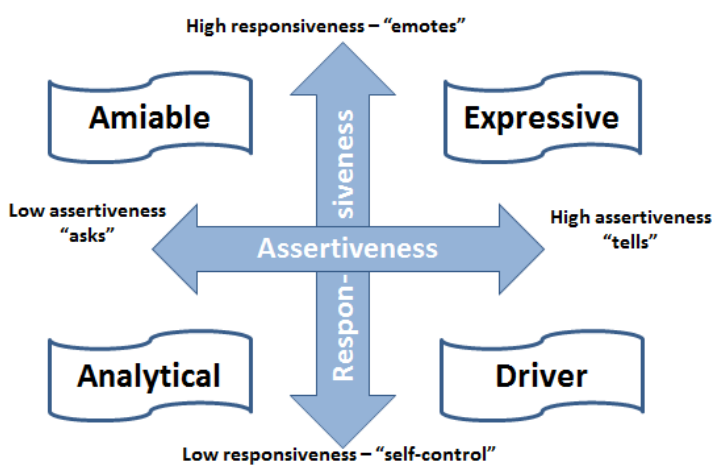
Figure 1. Social styles. Two-dimensional space defining the personality traits analyzed in this study. The “assertiveness” axis indicates the individual‘s tendency to impose their ideas or to go along with the ideas of the group. The “responsiveness” axis indicates the tendency to display one’s emotions, as opposed to emotional